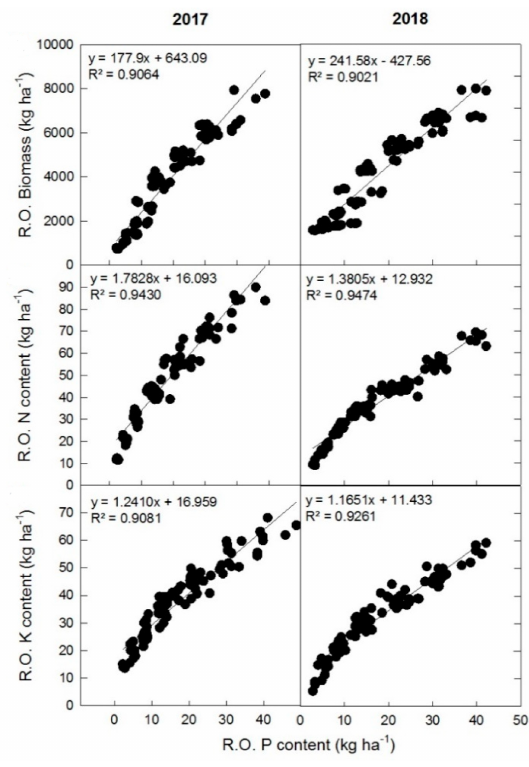
Figure 7. Relationship between accumulation of N, P, K, and biomass during 2017 and 2018 cropping seasons.